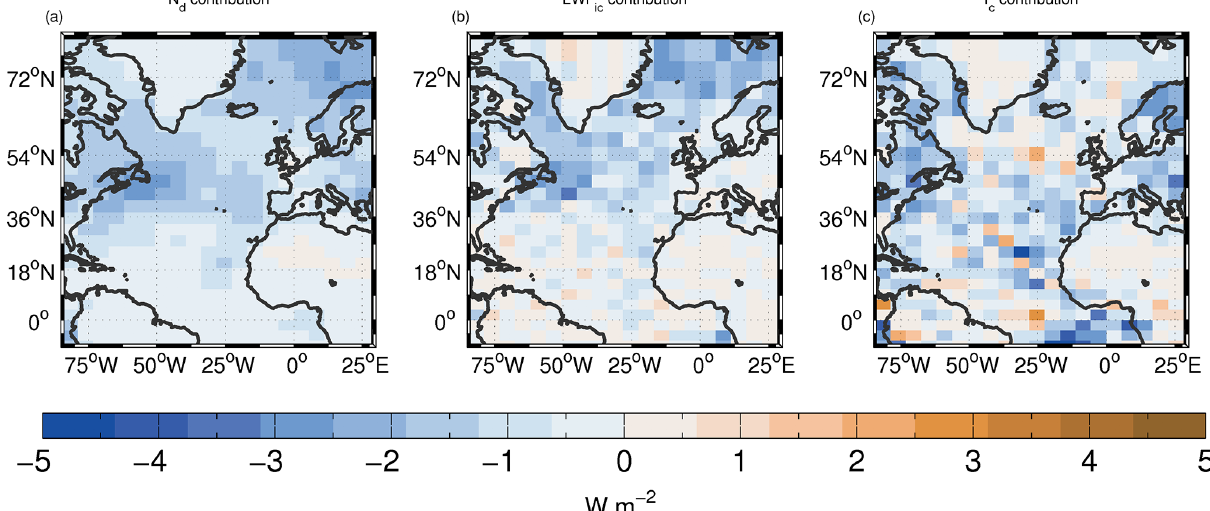
Figure H2. As for Fig. 15 except for the 2010–2011